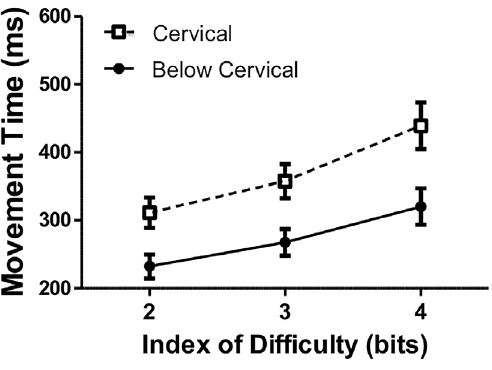
Figure 2. Mean movement times (ms) as a function of Group and Index of Difficulty for the execution task. Open symbols with dashed connecting lines represent data from the group with cervical SCI. Closed symbols with solid connecting lines represent data from the group with below cervical SCI. SEM bars are shown.